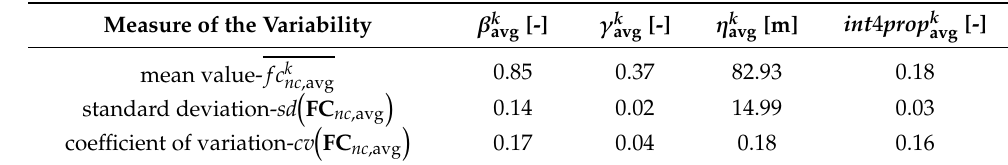
Table 5. Measures of the